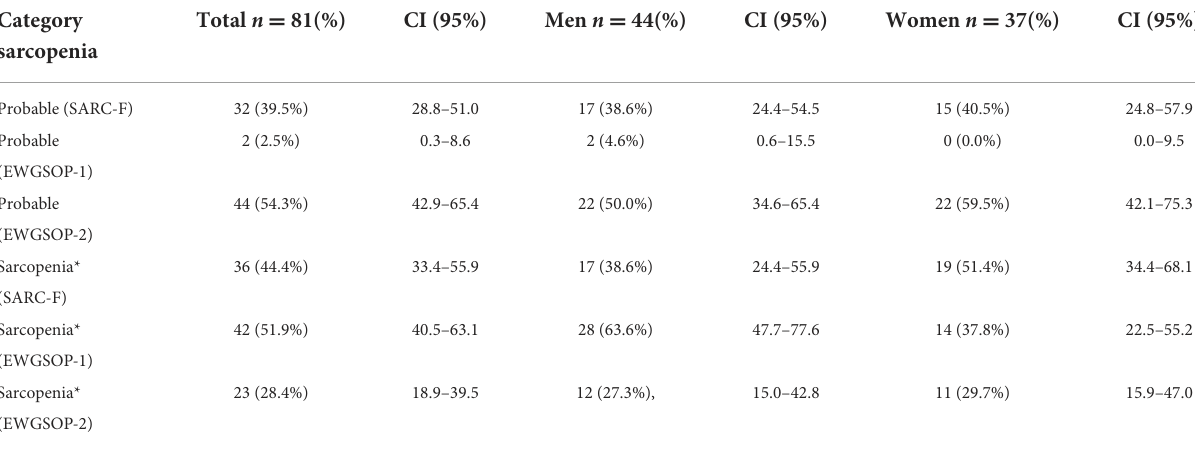
TABLE 3 Proportion of probable sarcopenia and sarcopenia according to different assessment tools.